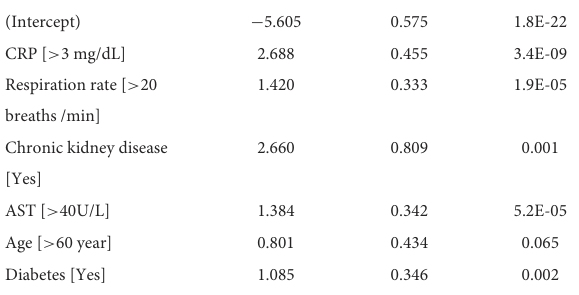
(B) Binary outcome: Below severe vs.